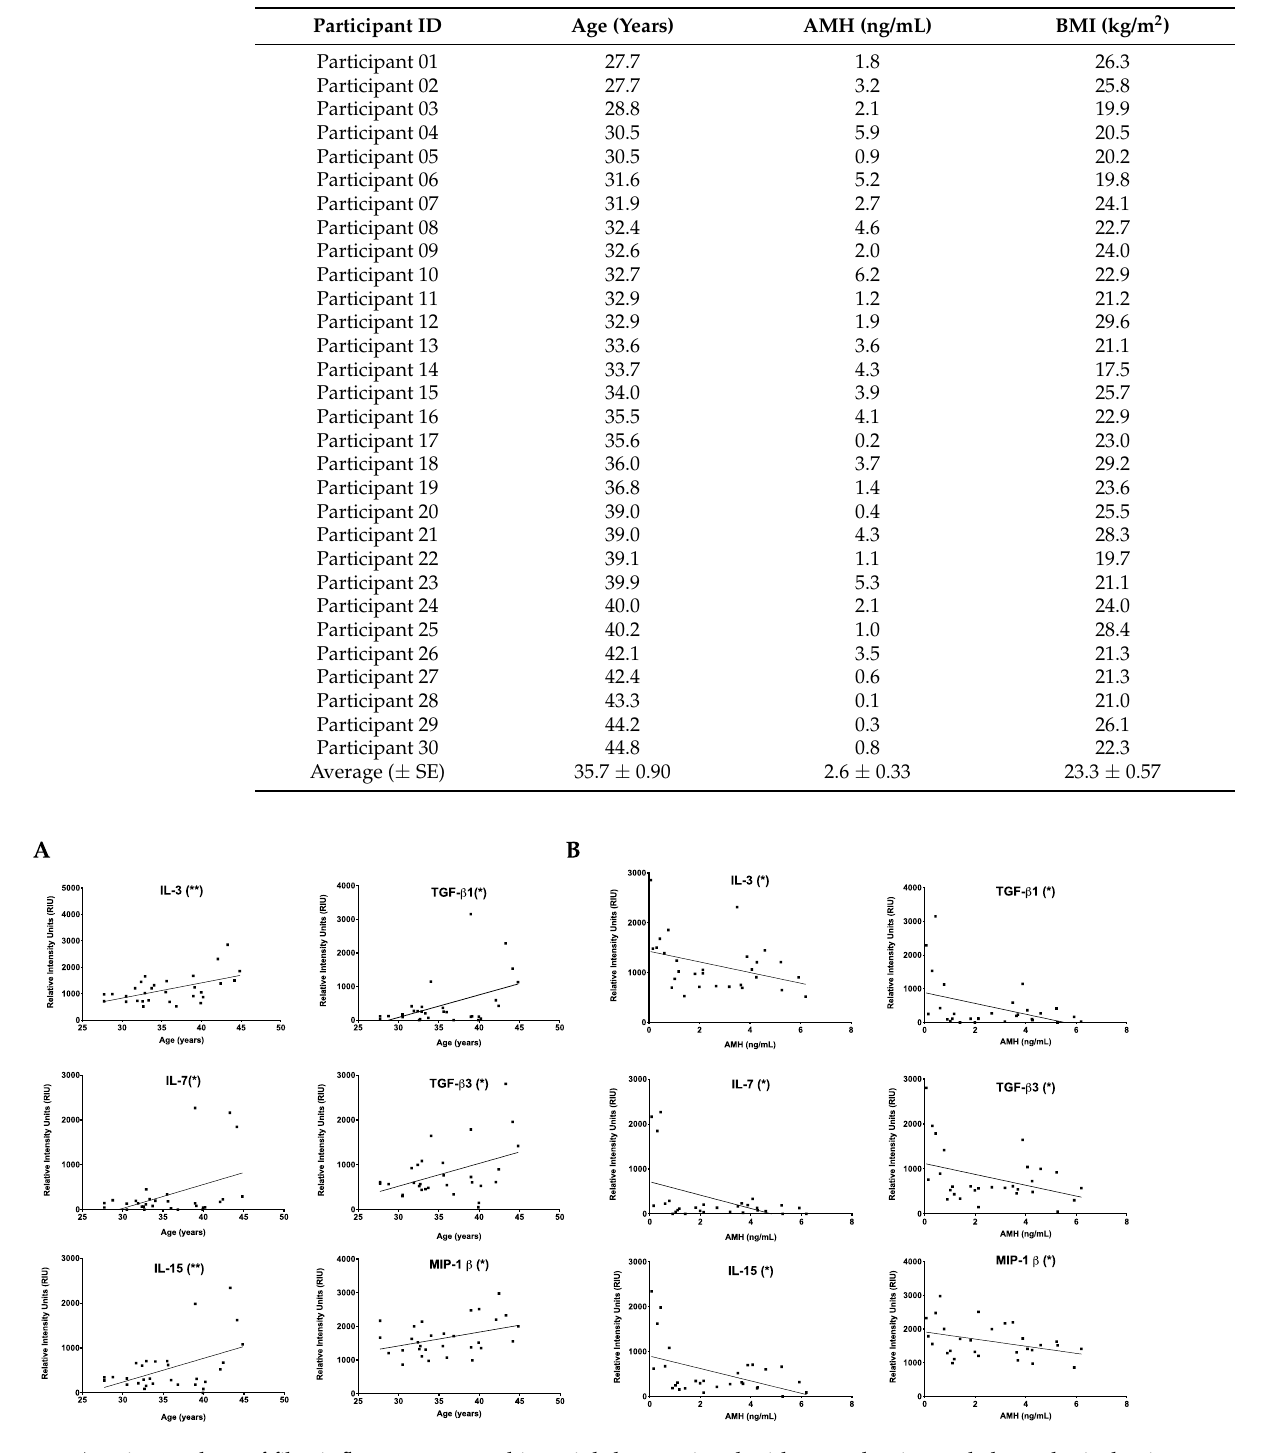
Table 1. Participant-specific health information.